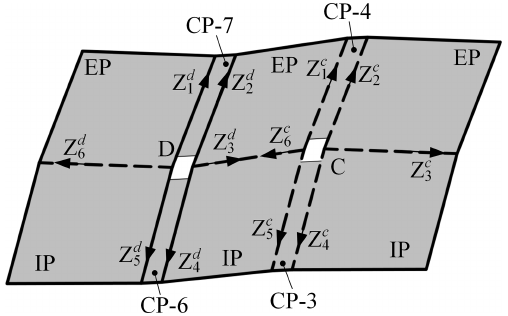
Figure 7. The combined mechanism consisting of U B -C and U S